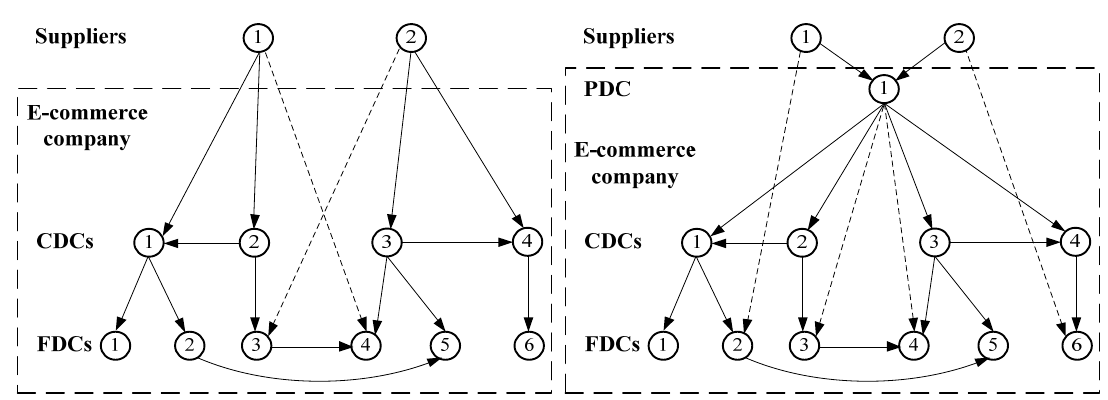
a. The distribution system without (left) and with (right) PDC, which is shown in Figure 4.